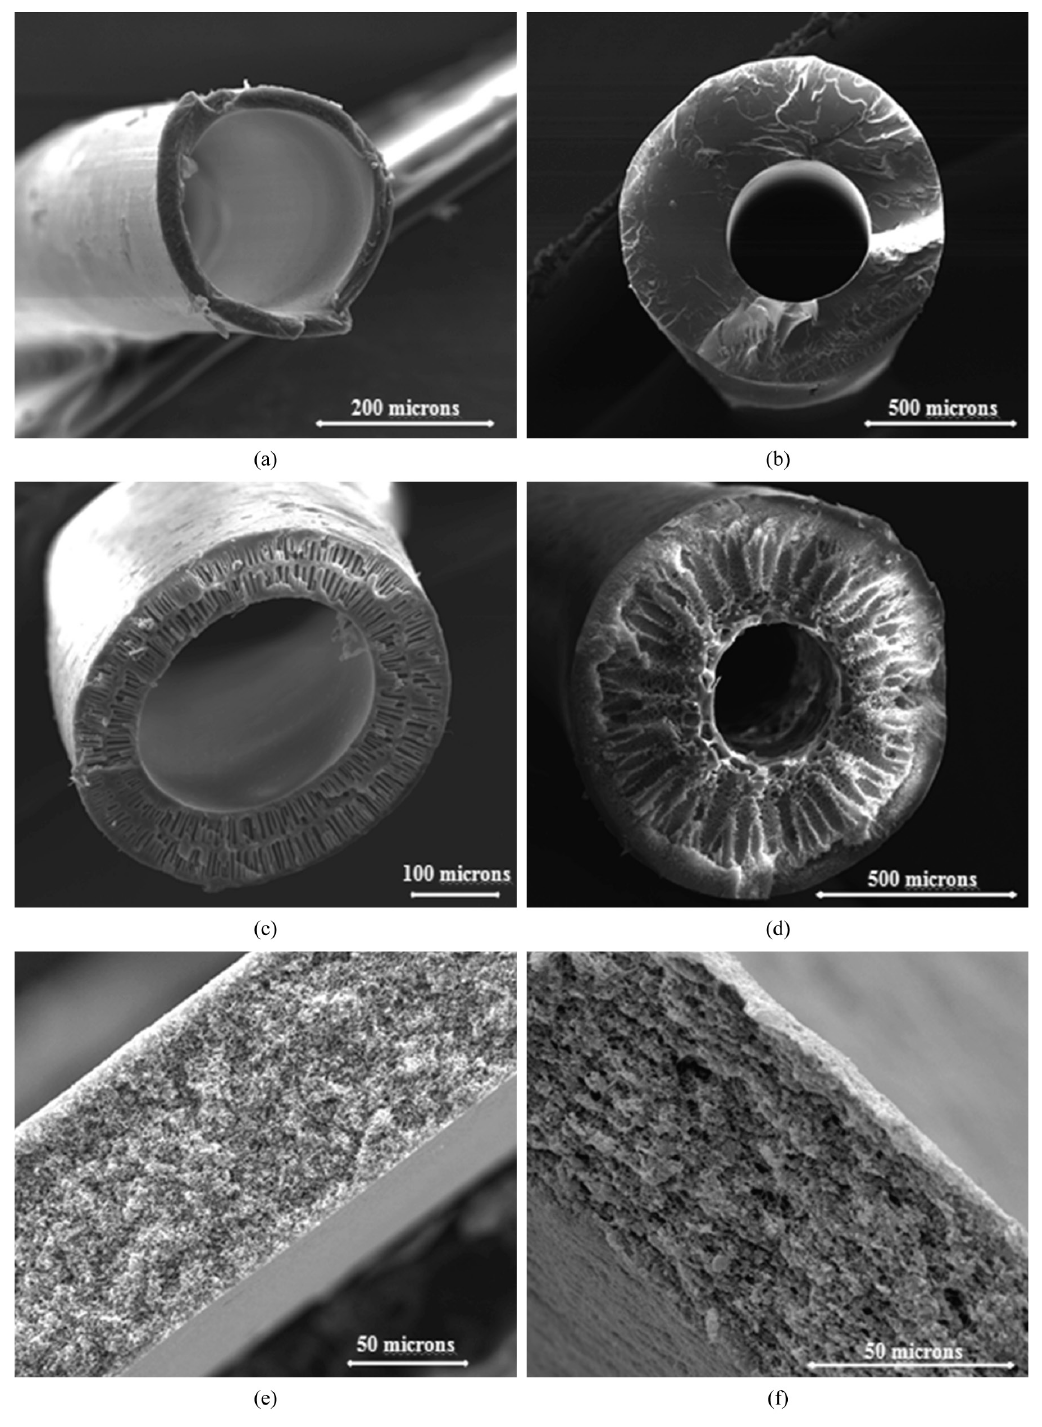
Figure 1. SEM photomicrographs of the cross section of polymeric membranes before the contact with ozone. (a) PP; (b) PDMS; (c) PES; (d) PEI; (e) PVDF and (f)